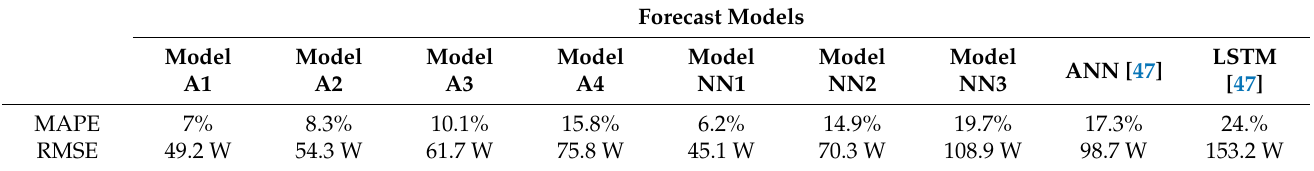
Table 7. Overall performance of short-term forecasting models over testing days. Forecast